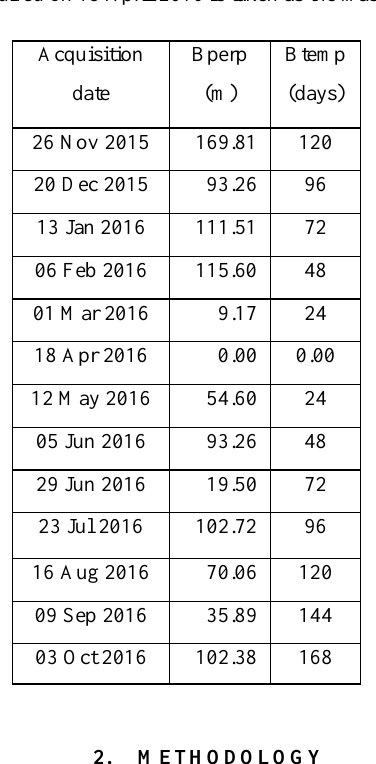
Figure 1. Google earth view of the Mussoorie region Table 1. Sentinel-1 TOPS dataset for the Mussoorie region. Image acquired on 18 April 2016 is taken as the master image.